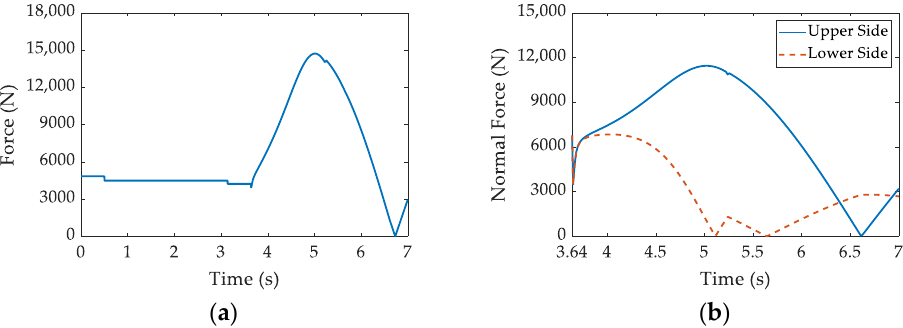
Figure 9. ( a ) Driving force required for the motion of the manipulator; ( b ) normal force of the manipulator acting on the track.